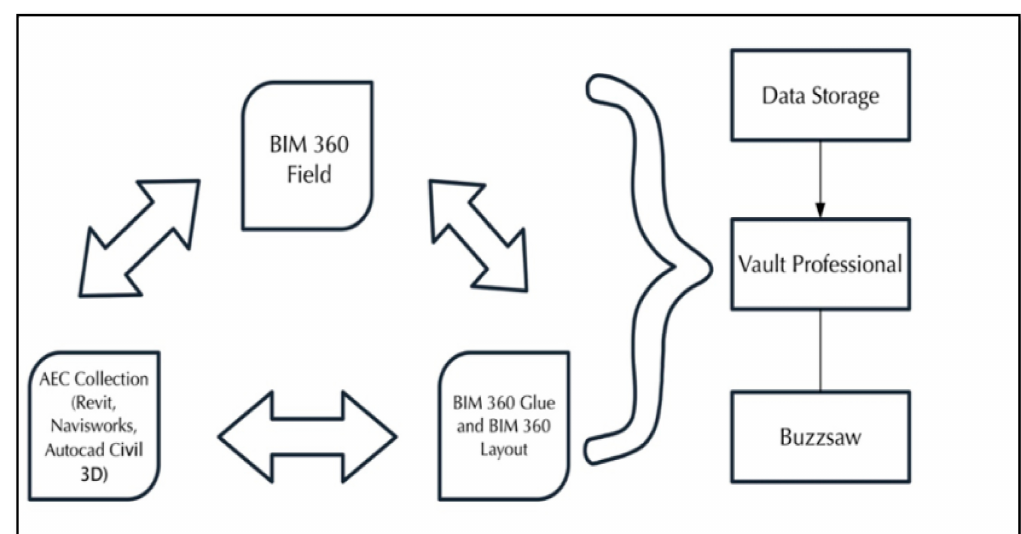
Figure 7. INA BIM Figure 7. INA BIM Tools.